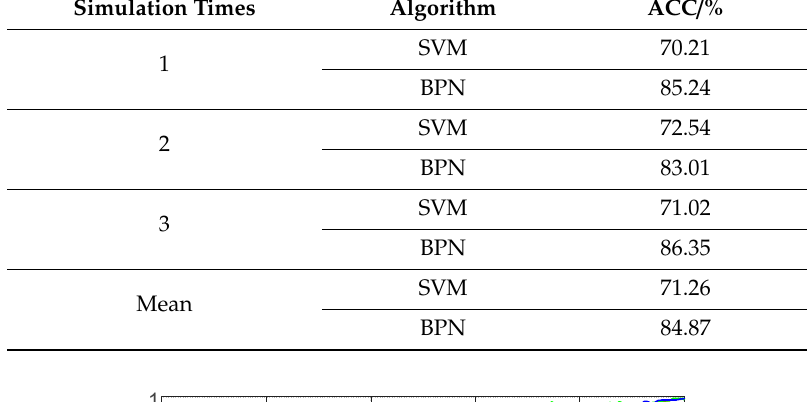
Table 5. Accuracy value of three algorithms.